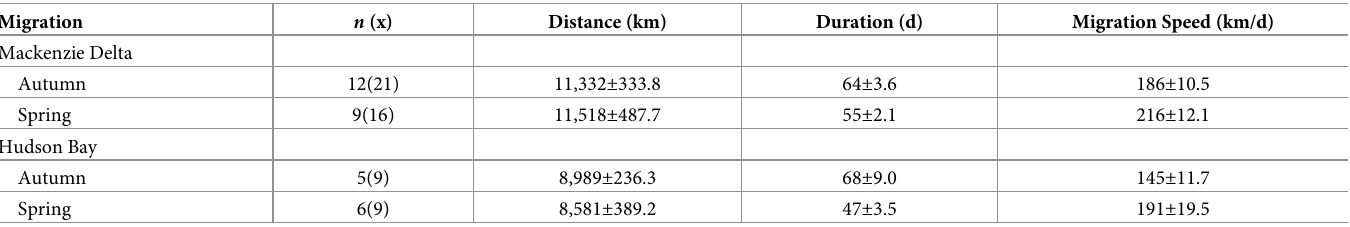
Table 3. Autumn and spring migration statistics for whimbrels from the Mackenzie Delta and Hudson Bay breeding populations as determined by satellite tracking (2008–2018). Migration Migration Speed (km/d) Mackenzie Delta Autumn Spring 216 ± 12.1 Hudson Bay Autumn 8,989 ± 236.3 145 ± 11.7 Spring 6(9) 8,581 ± 389.2 47 ± 3.5 191 ± 19.5 Sample sizes represent number of individuals (total number of seasons) on which values were